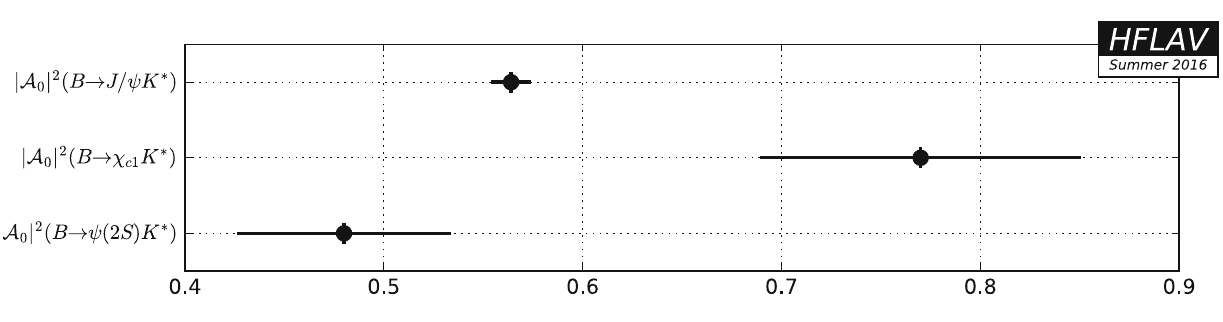
Fig. 148 Summary of the averages from Table 182